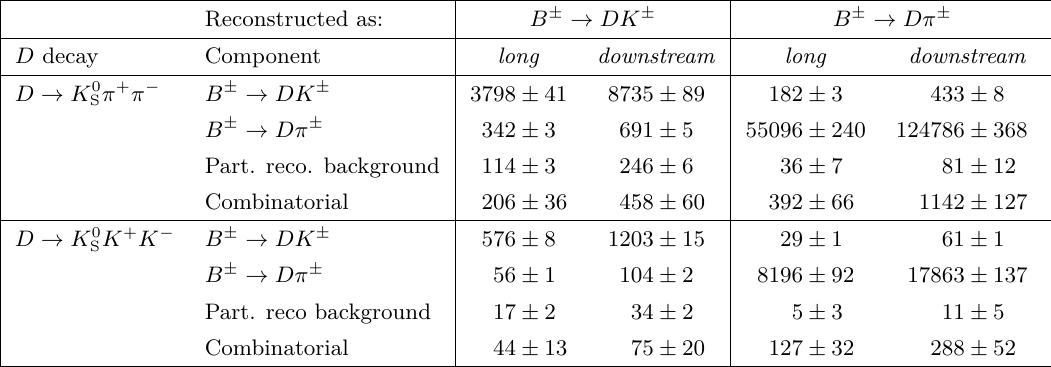
Table 1 . The signal and background yields in the region m B ∈ [5249 , 5309] MeV/ c 2 as obtained in the fit. For the B ± → DK ± candidates, the yield of the partially reconstructed background includes the contributions from B 0 decays and misidentified partially reconstructed s